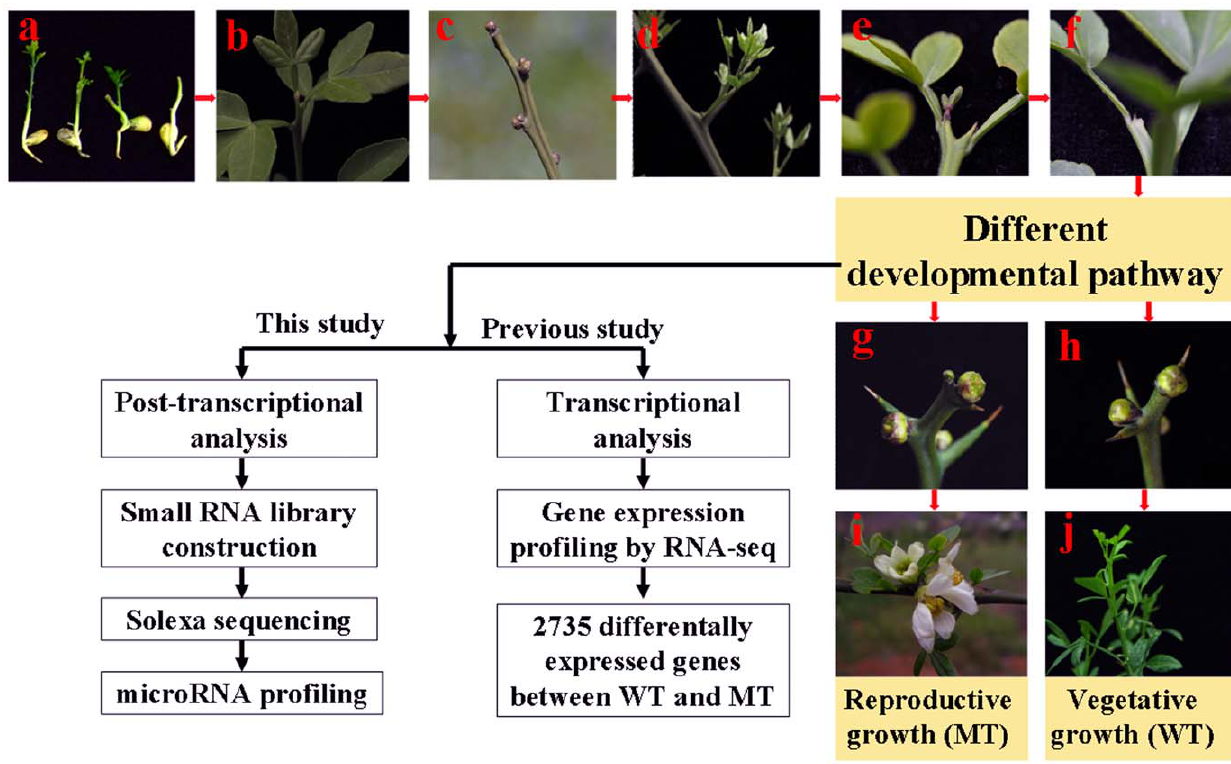
Figure 1. Schematic diagram of developmental stages involved in the flowering of precocious trifoliate orange. a, Seedling of precocious trifoliate orange. b, The shoot apical meristem of seedling begins self-pruning. c, The terminal bud and lateral buds of the juvenile trees became dormant after self-pruning. d, The lateral buds develop into a spring shoot in the next year. e, The spring shoot begins self-pruning. f, After self-pruning. g, The lateral bud becomes a leaf bud. h, The lateral bud becomes a floral bud. i, floral bud became flower. j, leaf bud became summer or autumn. The schematic presentation shows the strategy of transcriptional analysis by the Massive Parallel Signature Sequencing (previously) and post-transcriptional analysis by sRNA sequencing (this study) on the MT and